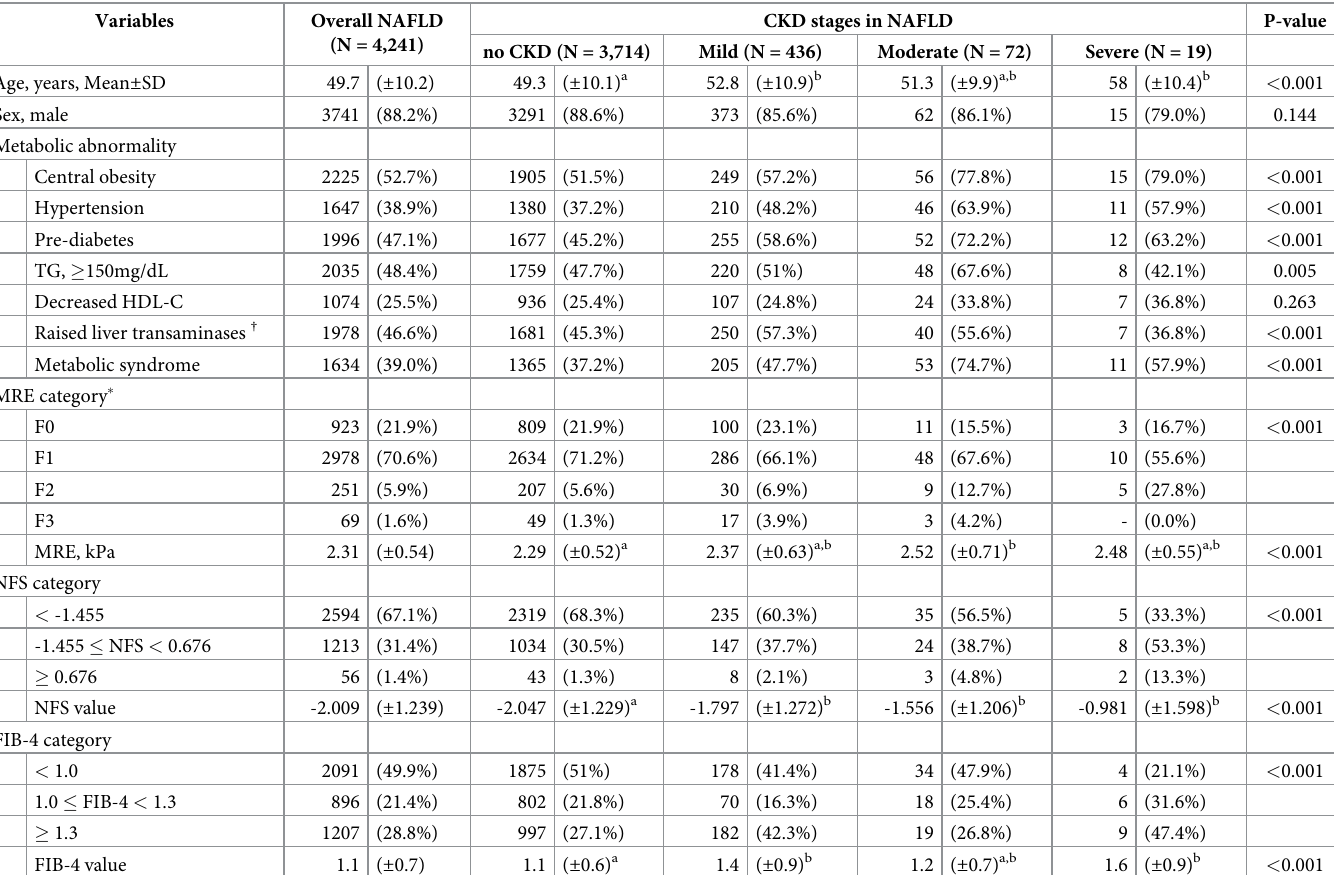
Table 3. Comparison of metabolic abnormalities and liver fibrosis according to CKD